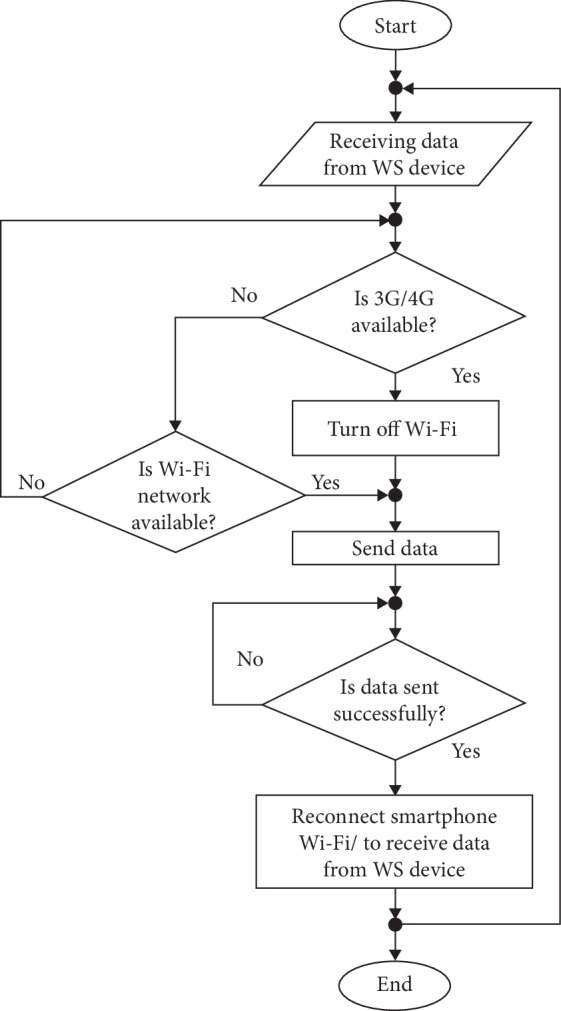
Smartphone Wi-Fi connection-reconnection sequence.